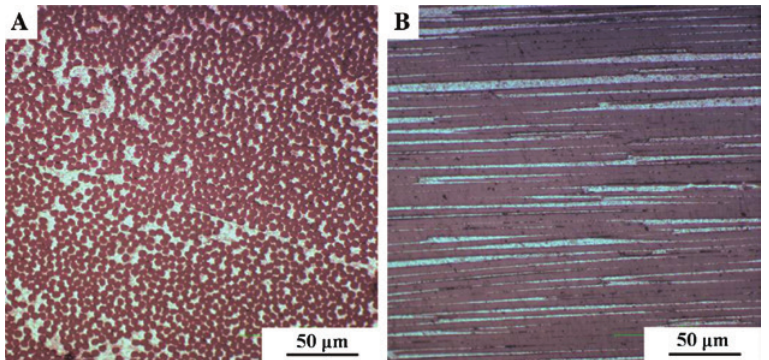
/Al composites in (A) transverse and (B) longitudinal Figure 1: Morphology of Gr f